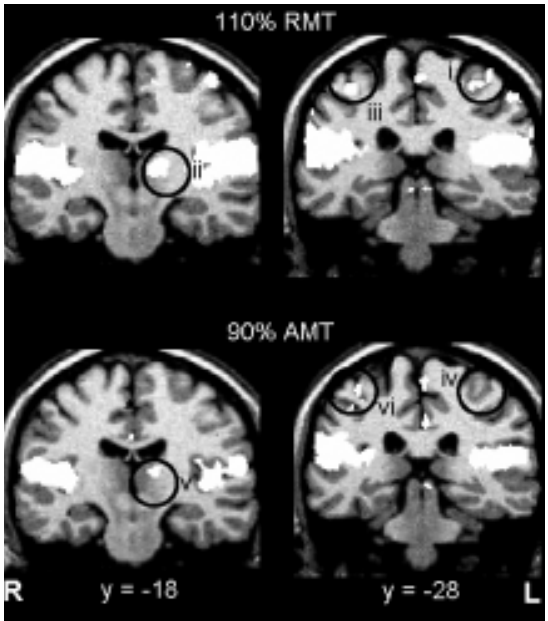
Fig. 2. Differences in the effects of sub- and suprathreshold rTMS on BOLD signal. BOLD signal increases during (top) suprathreshold rTMS (110% RMT), and (bottom) subthreshold rTMS (90% AMT). Apart from pronounced auditory activation, suprathreshold rTMS induced activations (red-yellow) in the left M1/S1 (i), and the left motor thalamus (ii). BOLD MRI signal decreases (iii) were observed in the right M1/S1. In the absence of peripheral muscle movements, subthreshold rTMS did not evoke significant changes at the site of stimulation (iv), while clear activity increases were observed in the left motor thalamic regions (v). A signal decrease was observed in the right M1/S1 (vi). N = 11 , P < 0 . 01 (corrected). Results are projected onto two coronal sections of a standard reference brain (MNI coordinates indicated). Used with permission from Bestmann et al. 2004